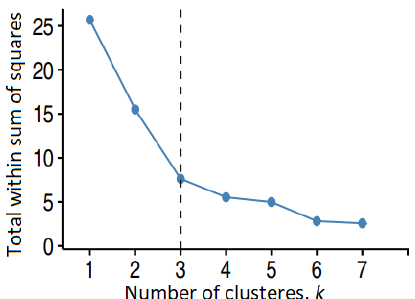
Figure 4. The elbow method for determining the optimal number of clusters for Group 1 in the k-means algorithm.